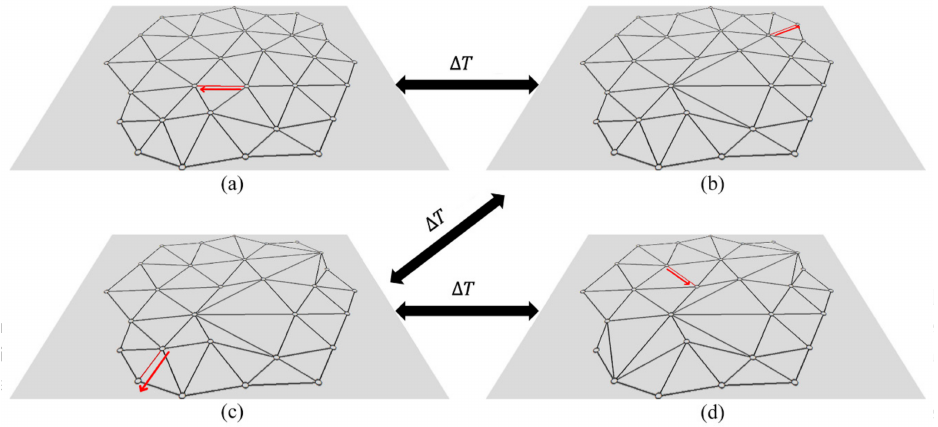
Figure 8. Triangular reconstruction based on ∆ T . ( a – d ) are simple representations of meshes at di ff erent levels, and each level is adjacent to the others. With the help of ∆ T , the transition of the adjacent hierarchical meshes can be